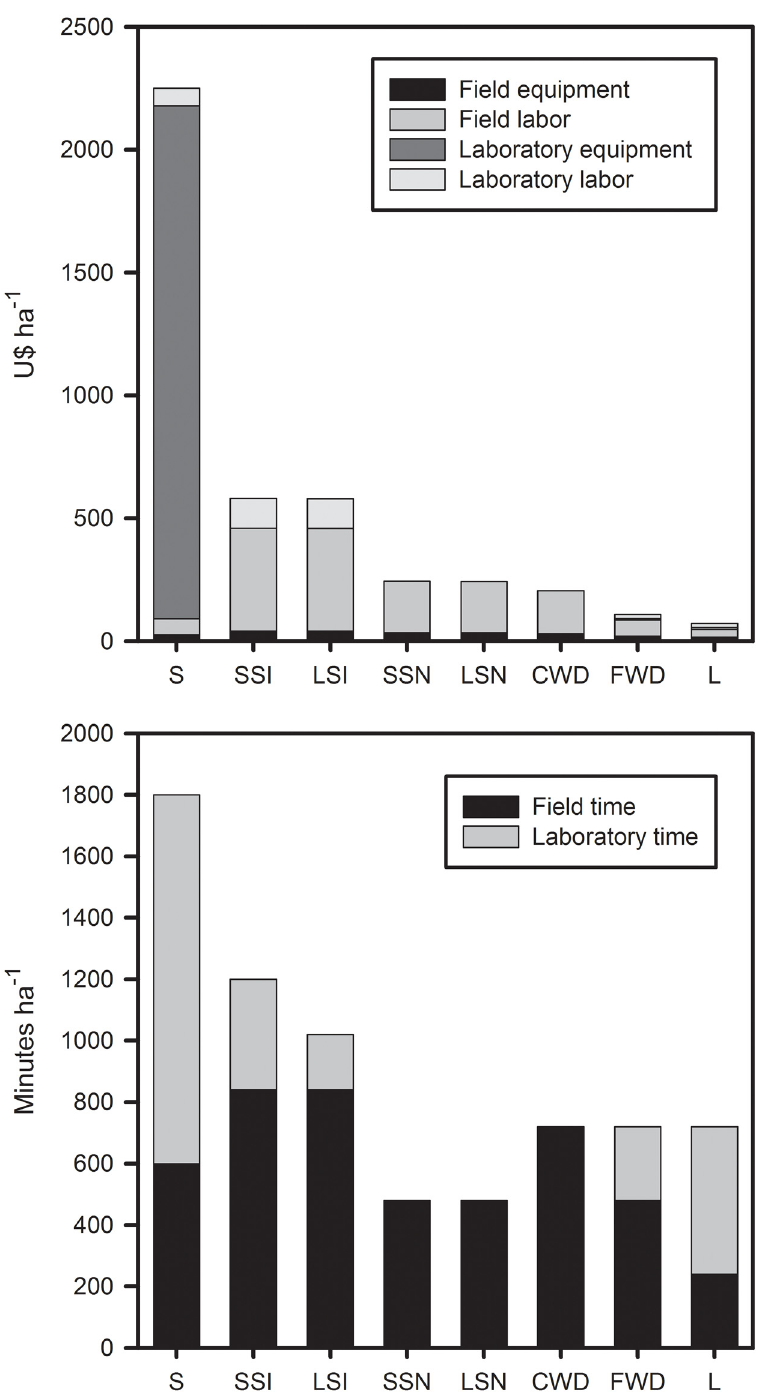
Fig 2. Financial costs and time spent sampling different components of the total carbon stocks. S = Soil 0-30cm, SSI = Small stems (2 – 9.9cm DBH) identified to species level, LSI = Large stems ( (cid:1) 10cm DBH) identified to species level, SSN = Small stems without species identification, LSN = Large stems without species identification, CWD = Coarse woody debris, FWD = Fine woody debris, L = Leaf litter. As live and dead stems were sampled together, it is impossible to disentangle their specific costs in this